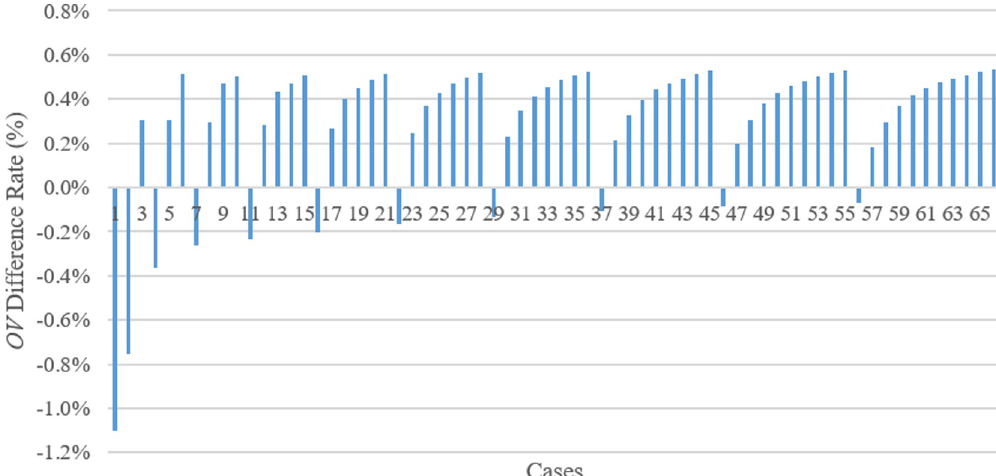
Fig 14. Comparison between WA and TSA in terms of OV difference rate.